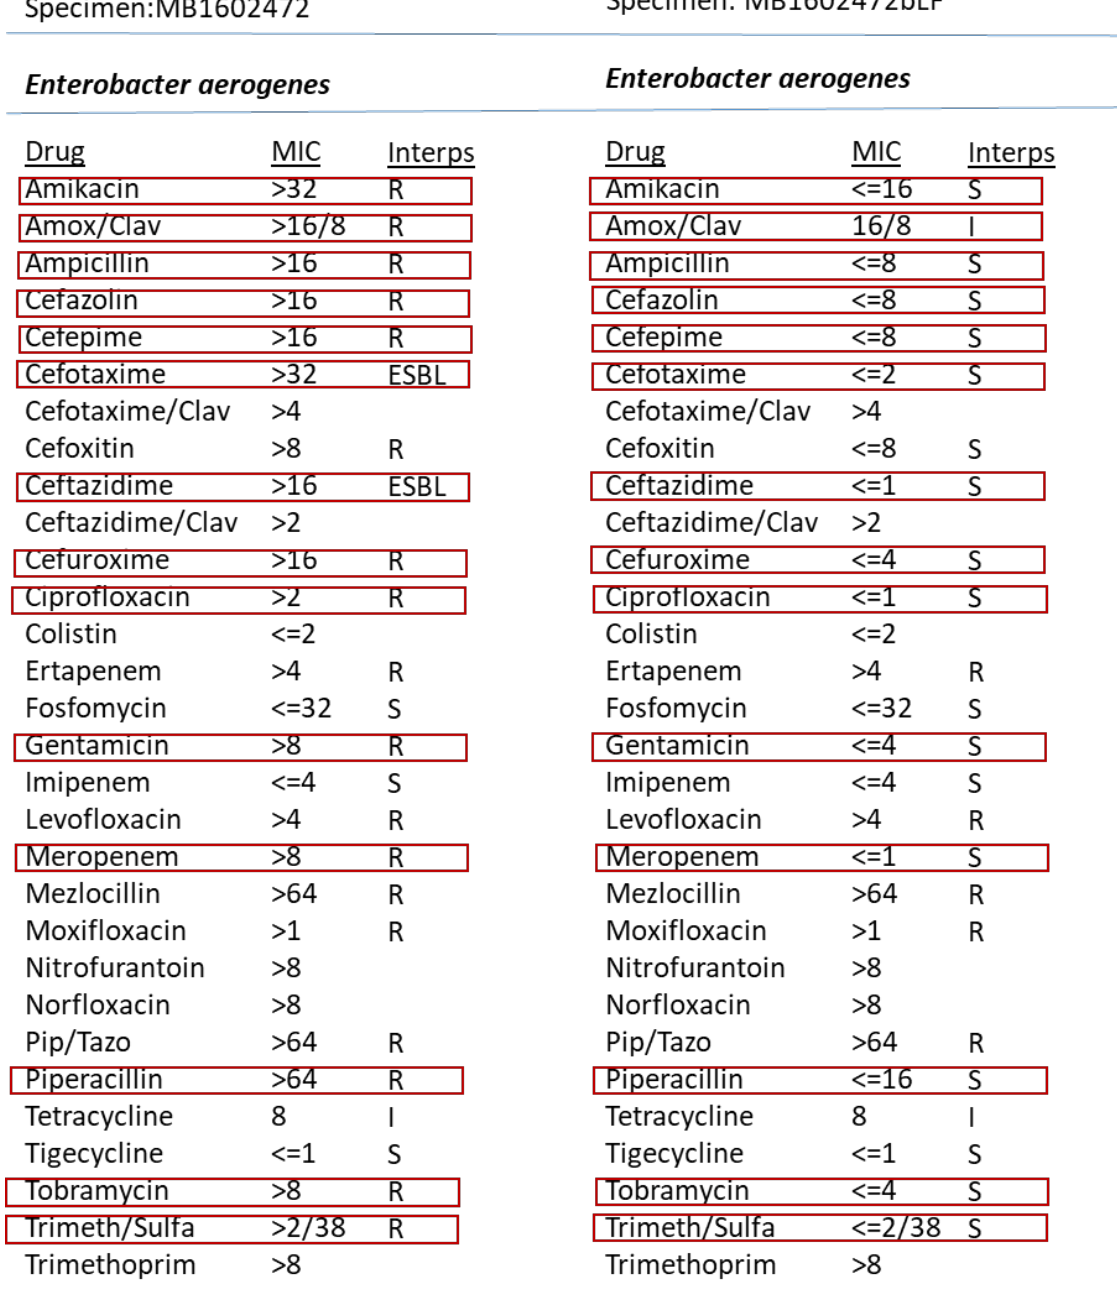
Figure 5. Demonstration of effect of bovine lactoferrin (bLF) on carbapenemase producing (cephalosporin and carbapenem resistant) clinical Enterobacter aerogenes .